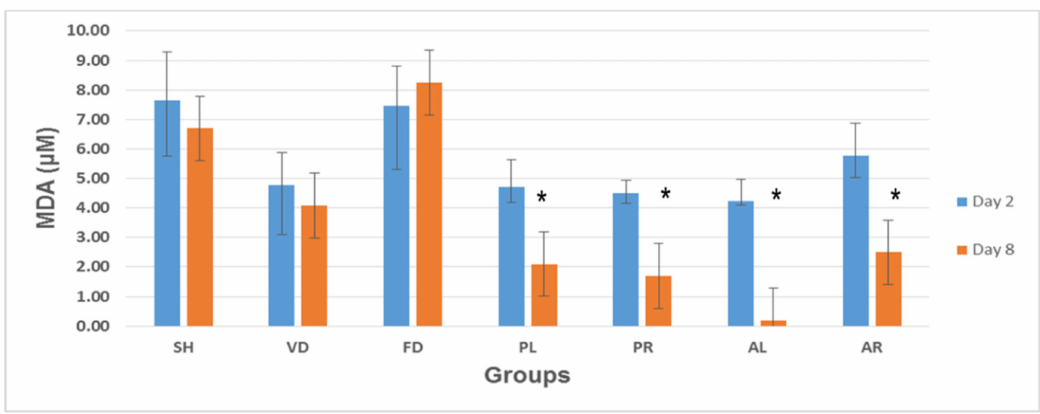
Figure 10. Malondialdehyde (MDA) levels in skin tissue of seven rat experimental groups: SH, VD, FD, PL, PR, AL, and AR. All data are given as mean ± S.E. for six animals in each group. Statistically significant results indicated as (*) p < 0.05 versus control groups (SH, VD, and FD) on the corresponding day. SH: sham control group (without treatment); VD: treated with vehicle (Cetomacrogol ointment); FD: treated with flavine (Acriflavine 0.1%); PL: treated with 1.0% concentration of MPvp leaves extract; PR: treated with 1.0% concentration of MPvp stem-roots extract; AL: treated with 2.0% concentration of MPva leaves extract; AR: treated with 2.0% concentration of MPva stem-roots